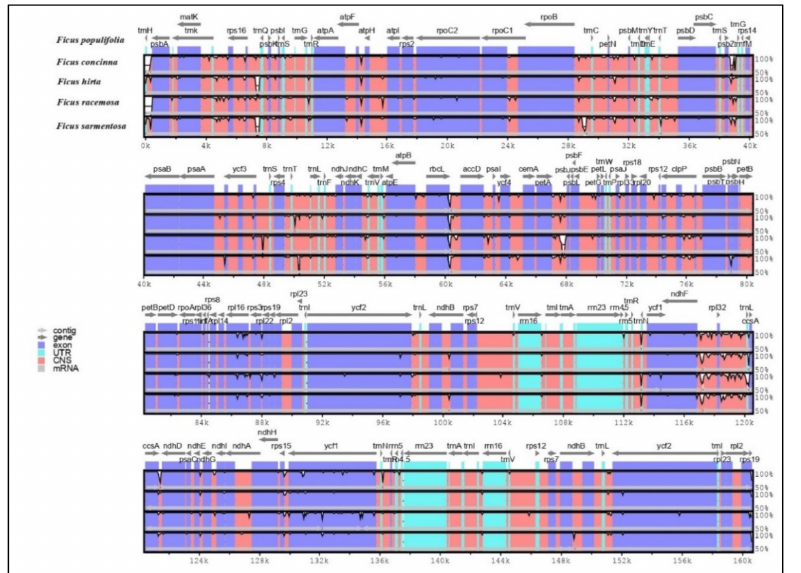
Figure 11. Visual alignment of five Ficus plastomes using Ficus populifolia as a reference. The y-axis displays the identity percentage (50%–100%), whereas the x-axis displays the genomic coordinate. The upper arrows represent the direction and position of each gene. CNS = conserved non-coding regions, UTR = untranslated region. The plot was created using the mVISTA program [32]. The protein-coding genes were mostly conserved except for rpoC2 , ycf2 , ycf1 , ndhF